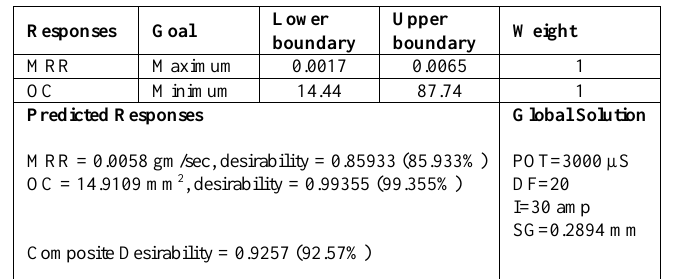
Table 4. Desirability function